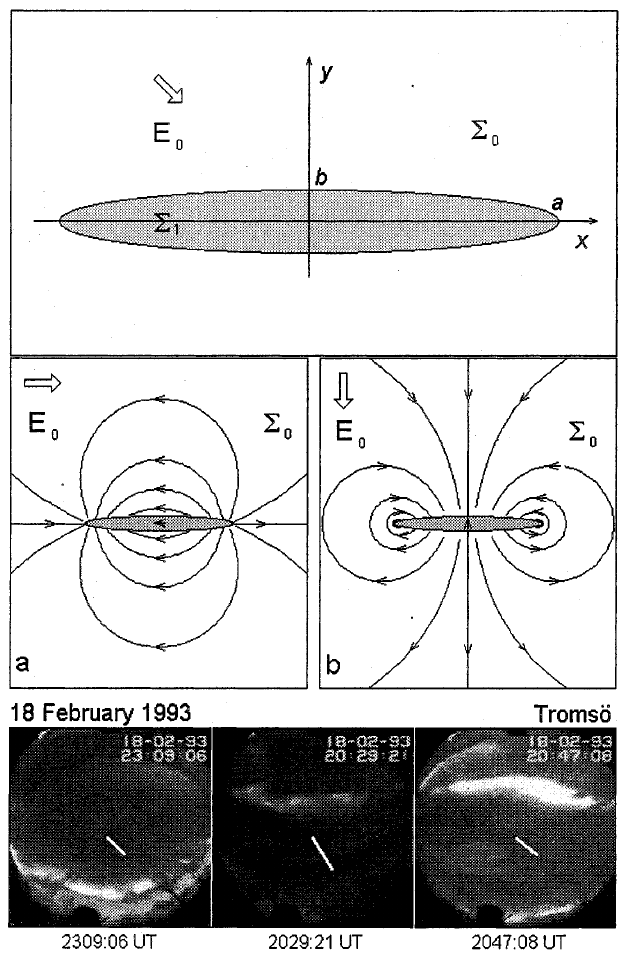
Fig. 5a, b. Elliptic inhomogeneity in the ionosphere; E undisturbed background electric field and conductivity, respectively, and S refers to the region of enhanced conductivity ( top panel ). The 1 distribution of polarization electric fields generated by the ionospheric inhomogeneity orientated along ( central panel , a ) and across ( central panel , b ) the ionospheric electric field. The images showing the orientation of the arcs under consideration relatively the ionospheric electric field ( bottom panel